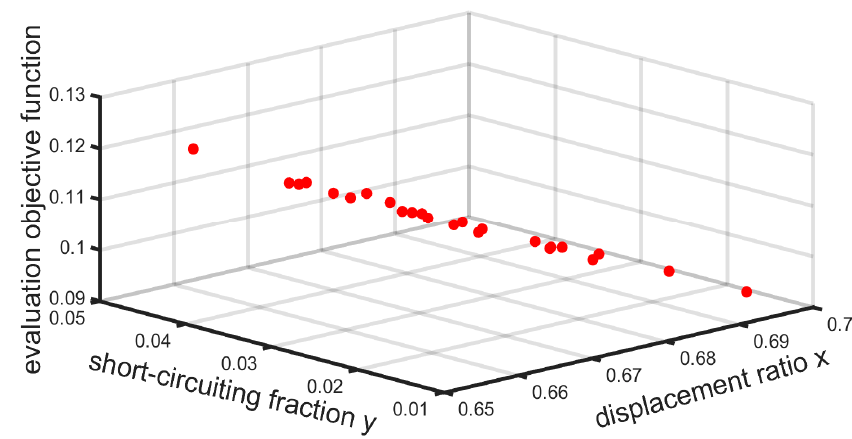
Table 9. Comparison results between the prototype engine and optimal design. Parameter